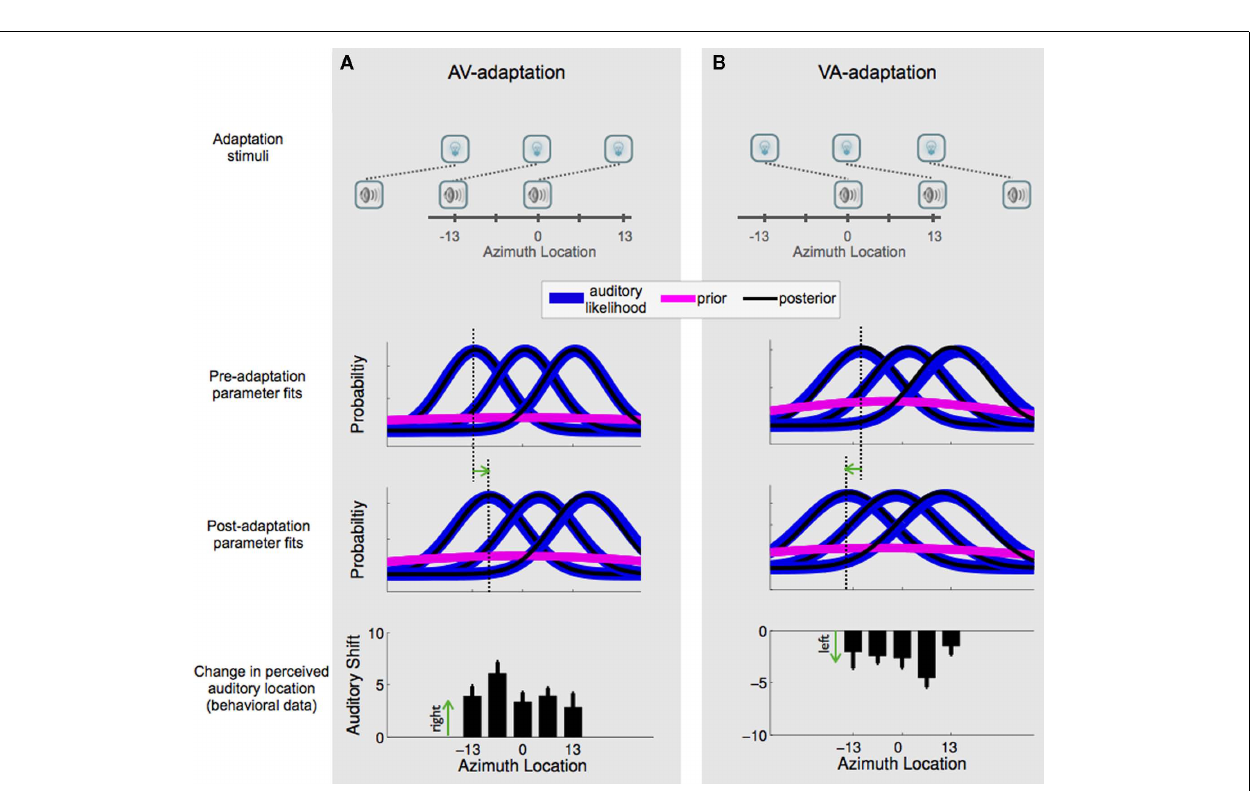
FIGURE 6 | Graphical representation of the results. The top row schematically shows three of the five stimulus configurations for the AV-adaptation group (A) andVA-adaptation group (B) .The Gaussian distributions in the second and third rows show the auditory likelihood, prior, and posterior distributions for the pre-adaptation and post-adaptation model fits, constructed with the parameters obtained from the data and shown in